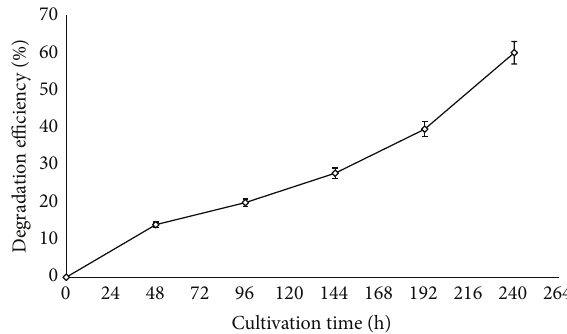
Figure 1: Effect of cultivation time on degradation of corn cob by S. carnis (error bars represent mean values and standard deviation of triplicate determination).